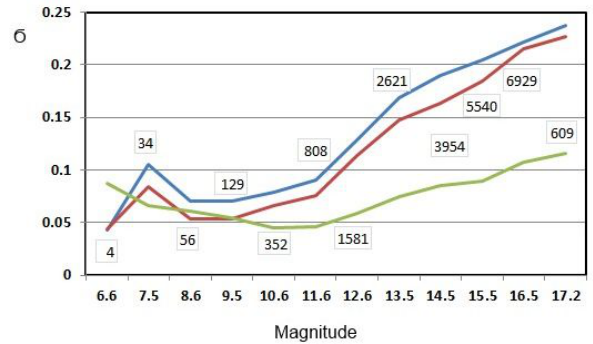
Figure 4. Root mean square errors the equatorial coordinates (RA – Blue line, DEC – red line) and magnitudes (U(ph) – green line) for different intervals of U(ph). Number of stars in the interval is given by numbers.